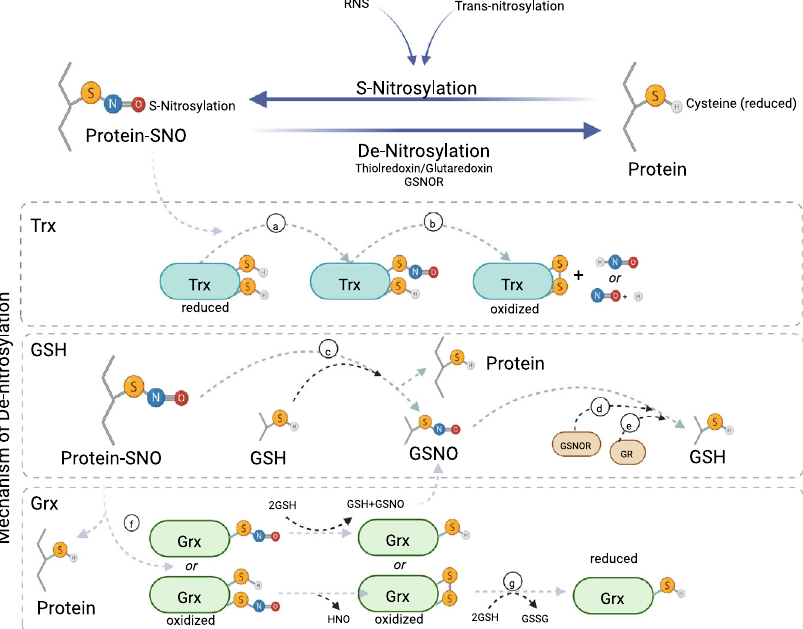
Fig. 4 Major pathways of protein de-nitrosylation. Two major de-nitrosylation pathways reduce s-nitrosocysteine in cells: the thioredoxin reductase (Trx) family of redox sensors that includes Glutaredoxin (Grx), and the indirect S-nitrosoglutathione reductase (GSNOR) system. a Trx removes the s-nitrosyl-group from the protein-SNO (either through Trx-mediated trans-nitrosylation or Trx-disul fi de-bond formation within the protein-SNO) and then b generates a disul fi de bond, freeing HON or NO + H + . Alternatively, the GSNOR system c fi rst requires that glutathione (GSH) react with the s-nitrosocysteine of an S-nitrosylated protein, transferring the nitrosyl-group to the thiol of the cysteinyl- group of GSH generating GSNO. d Next, the enzyme S-nitrosoglutathione reductase (GSNOR) and co-enzyme NADH catalyzes the conversion of GSNO to an N-hydrosul fi namide (GSNOH) intermediate and subsequently to glutathione-disul fi de (protein-GSSG) and hydroxylamine (not shown). e Protein-GSSG is then reduced to GSH through the activity of glutathione reductase (GR) and co-enzyme NADPH. f The Grx member of the Trx family has two modes of SNO reduction. Grx can form an oxidized Grx intermediate (Grx-SNO) on one cysteine residue following transfer of the nitrosyl-group from protein-SNO. This can either be reduced though the GSH pathway described above (mono-thiol reaction) or through the traditional Trx system (diol-thiol reaction) by producing a disul fi de bond. g The now oxidized Grx is reduced by two GSH molecules to restore the cycle. This fi gure was created using